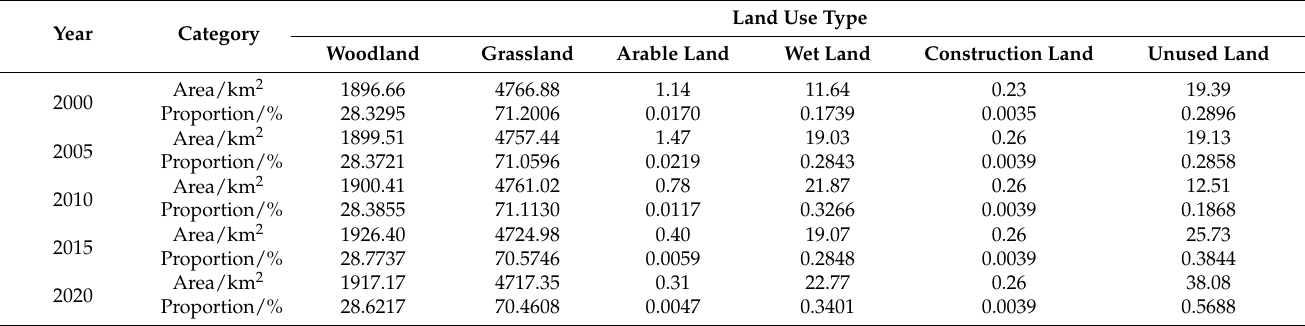
Table 9. The area of each land type in Rangtang